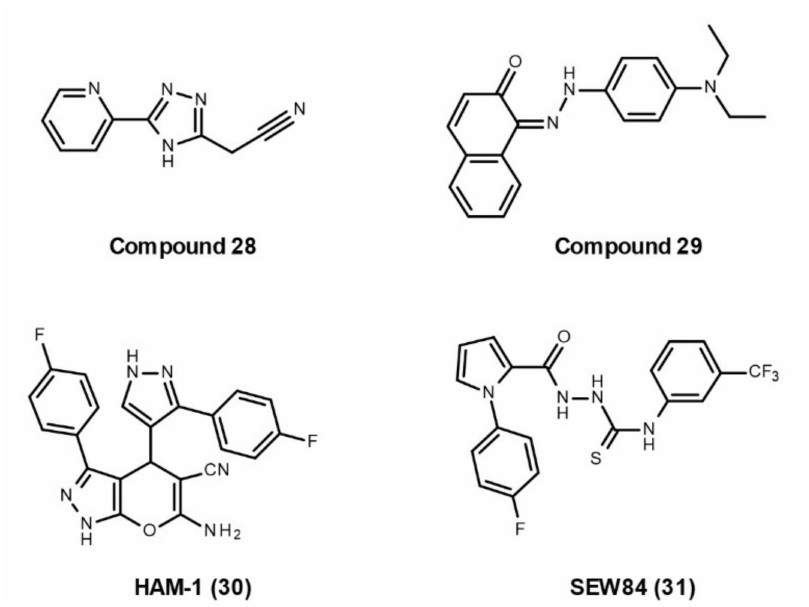
Figure 6. Developed small molecules with the ability to disrupt Hsp90–Aha1